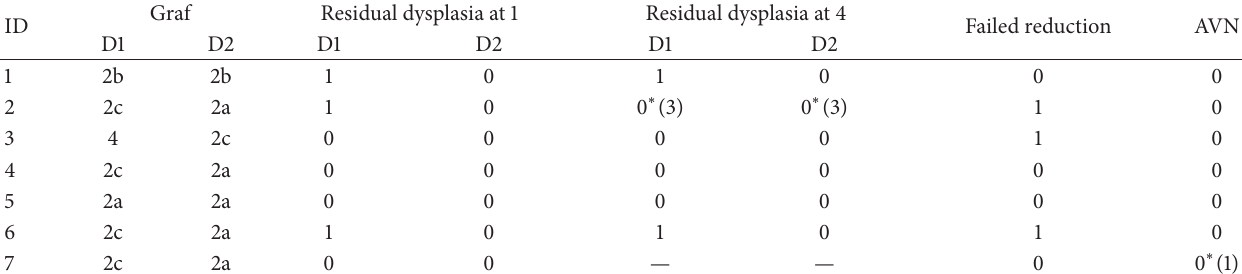
Table 4: Values of bilateral